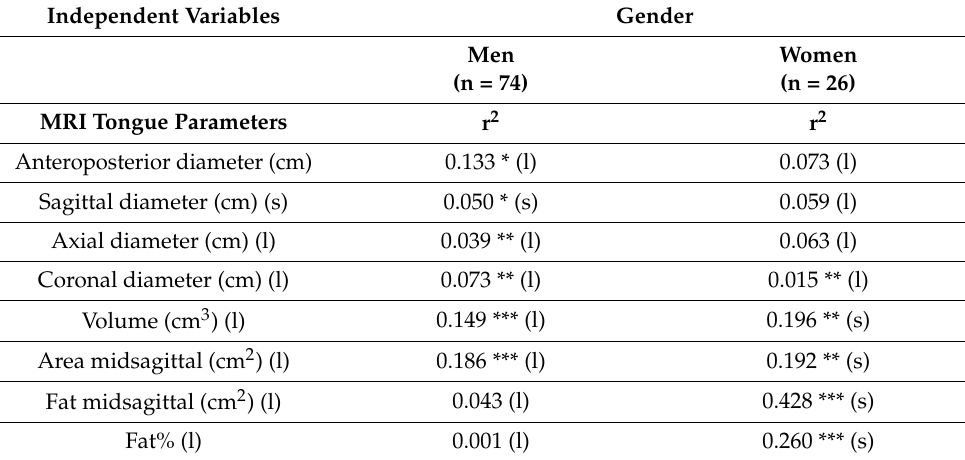
Table 3. Stochastic relationship between MRI parameters and AHI in male and female patients. Parameters show the r 2 (determination coefficient) values. *** indicates the significant difference at p < 0.01 level, whereas ** the significant difference at p < 0.05 level and * the significant difference at p < 0.1. (l): linear estimation, (s): sigmoid estimation. Independent Variables